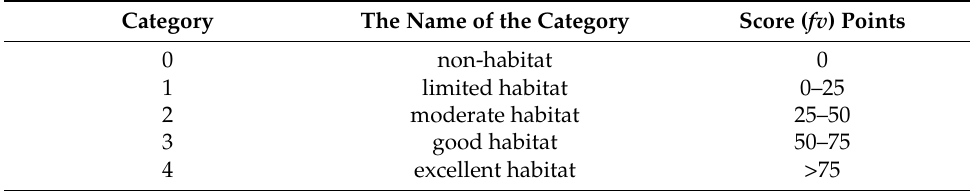
Table 2. Reclassification of the score given, by habitat favourability categories. Category The Name of the